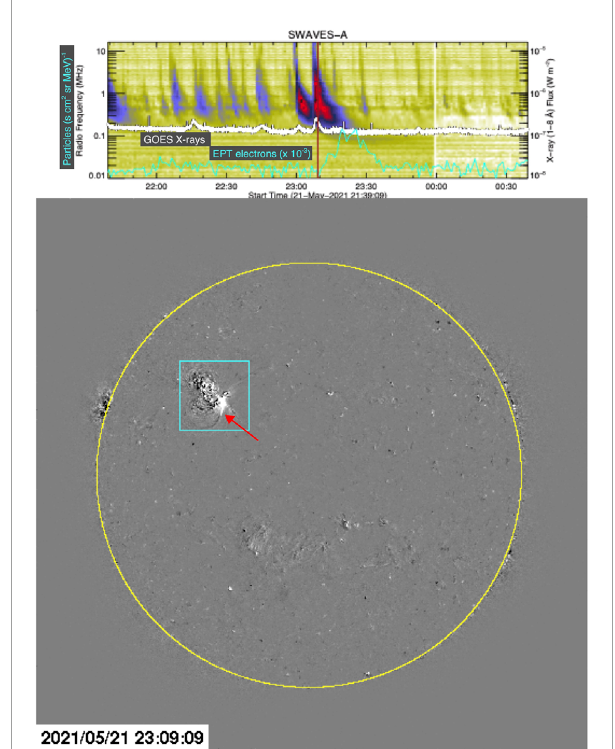
FIGURE 4 Snapshot from a movie of AIA 211 Å full-disk running-difference images taken at the time indicated by a brown line in the upper panel that shows radio dynamic spectra in the ± 1.5 h interval. The red arrow points to a jet. The yellow circle indicates the solar disk. The upper panel also includes the GOES soft X-ray (1–8 Å light curve (white) and the 40–102 keV electron time profile as recorded (cyan). The electron flux (particles cm 2 sr MeV) −1 is multiplied by 2 × 10 −4 to be scaled with the y-axis on the left.